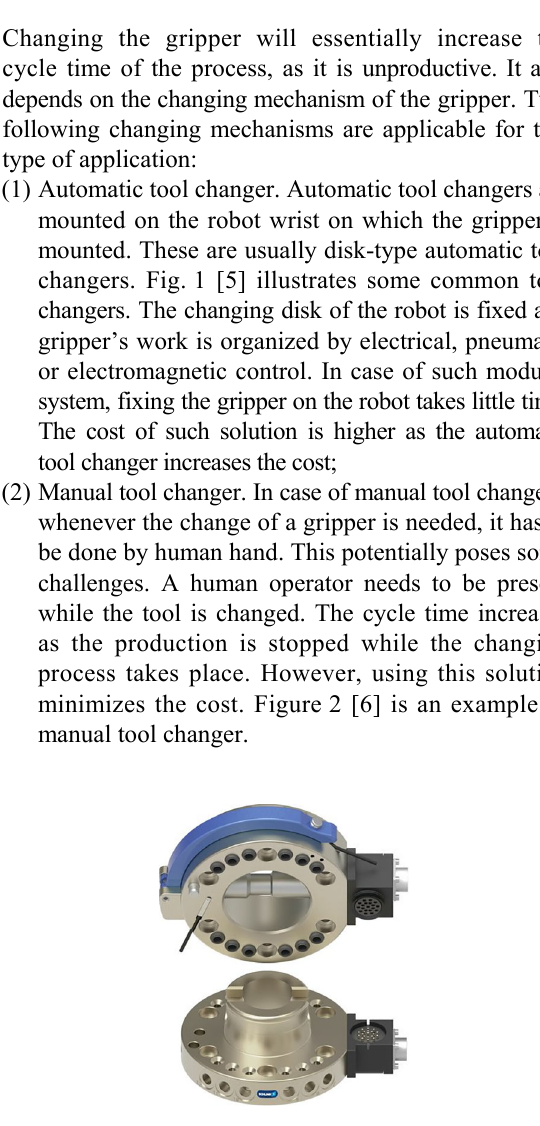
Fig. 1. Automatic tool changer [5].